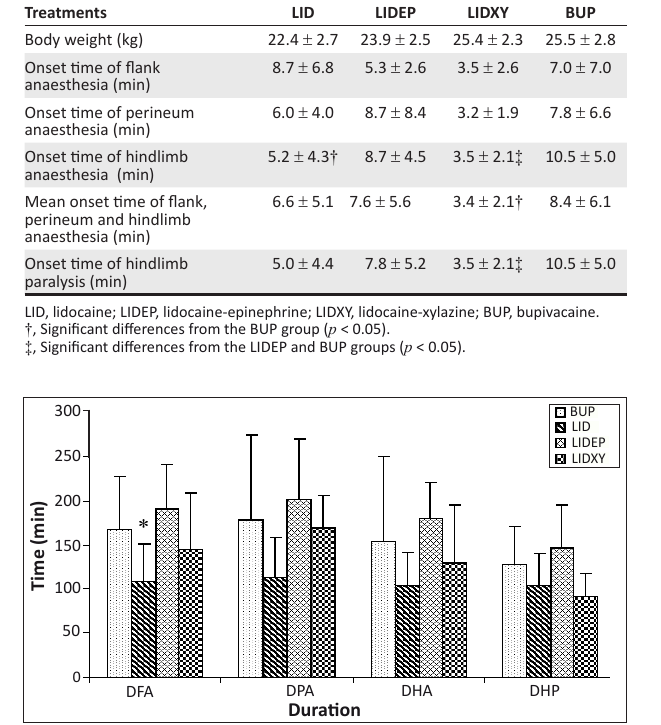
TABLE 1: Mean ± s.d. body weight, distance to epidural space, onset time (min) for flank (OFA), perineum (OPA) and hindlimb (OHA) analgesia and onset time for hindlimb paralysis (OHP) in sheep ( n = 6) receiving epidural, lidocaine, lidocaine-epinephrine, lidocaine-xylazine or bupivacaine solutions. Treatments